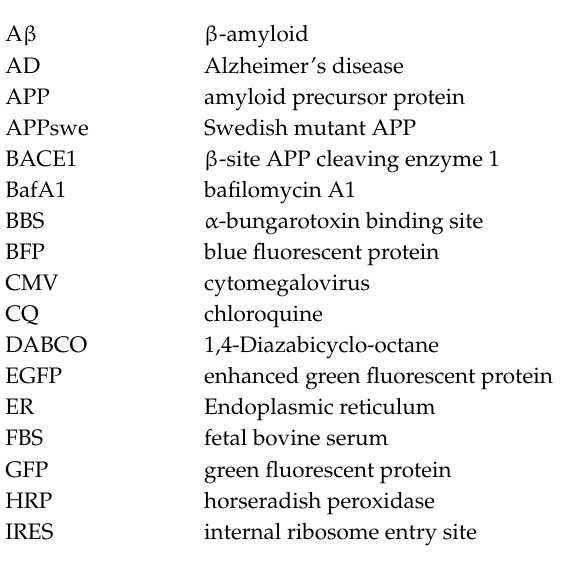
Figure S1: Response of NLT cells expressing BACE1-mCherry-EGFP to CQ treatment; Figure S2: Response of NLT cells expressing pHluorin-BACE1-mCherry to LY2886721; Figure S3: Regulation of pHluorin-BACE1-mCherry and BACE1 activity by APP in NLT